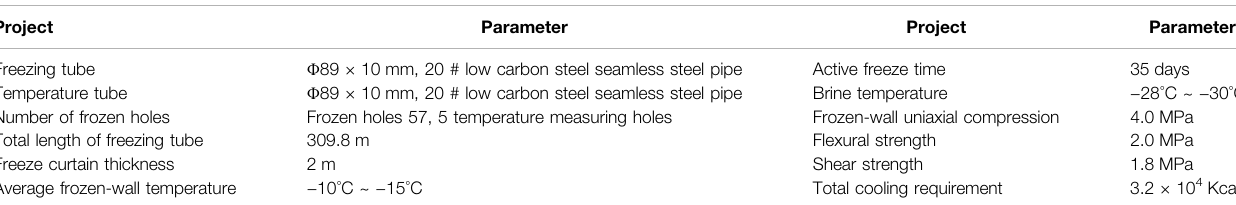
TABLE 1 | Frozen-curtain